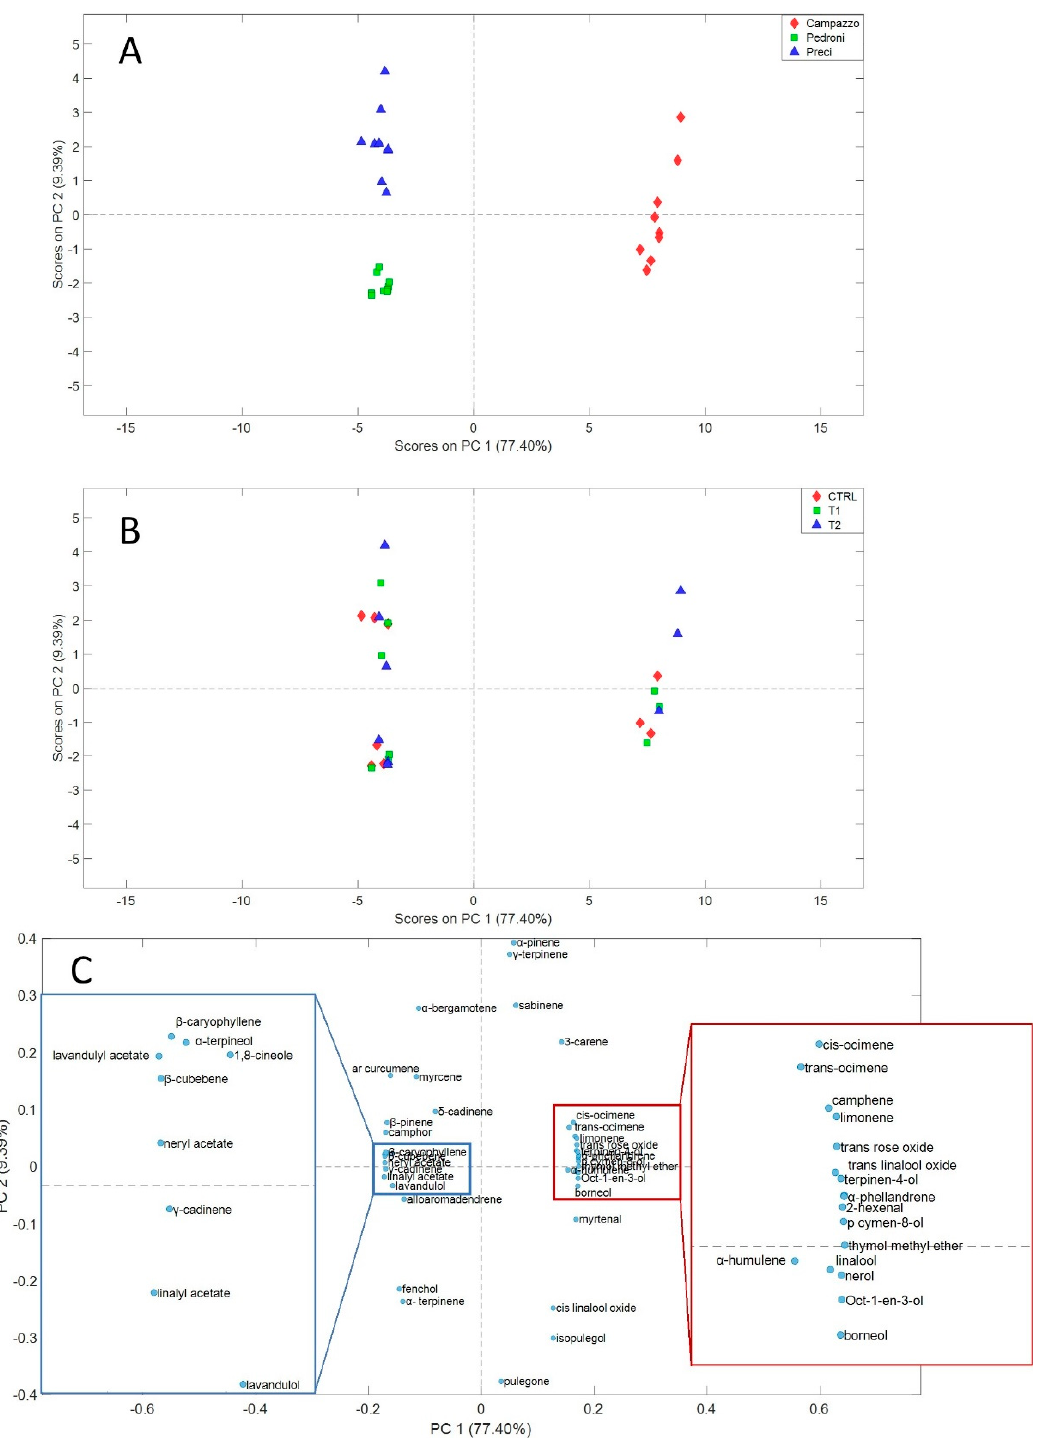
Figure 4. Principal component analysis (PCA) biplot for the chemical composition of EOs from 2020/2021. ( A ) Score plot labelling the farms and ( B ) the treatments; ( C ) loading plot. CA, Campazzo; PE, Pedroni; PR, Preci; CTRL, control with foliar application of tap water; T1, foliar application of FITOSTIM; T2, foliar application of FITOSTIM ALGA.